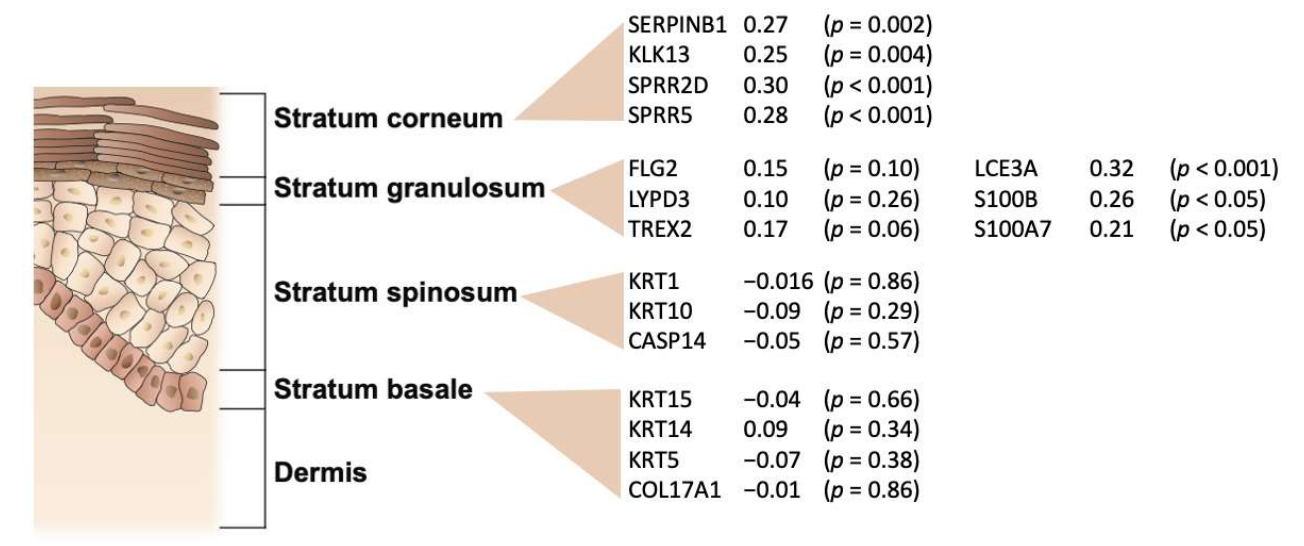
Figure 7. Correlation between gene expression detected in tape-stripped skin and matched full- thickness skin punch biopsies for selected epidermal layer marker genes [16]. Data shown are gene symbol, Spearman correlation coefficient, and p -value.